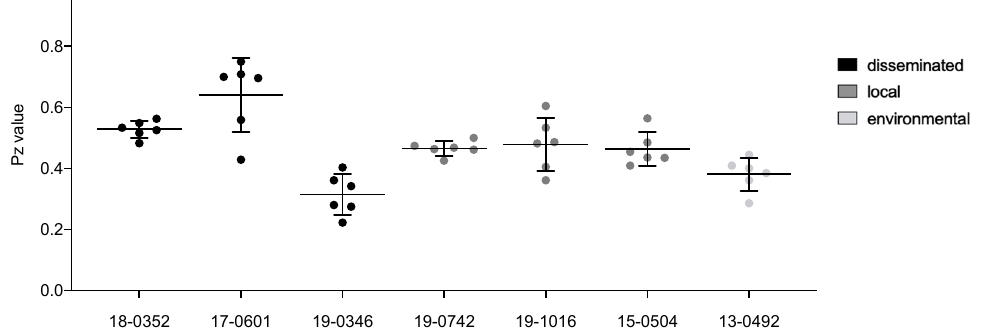
Figure 4. Phospholipase activity of Cryptococcus neoformans var. neoformans isolates from disseminated infections (black), localized soft tissue infections (grey), and the environment (light grey). A total of 5 µL containing 10 6 cells were spotted on egg yolk agar and incubated at 30 °C for five days. Halos surrounding colonies were measured digitally. Black lines show means with standard deviation of three biological replicates with two measurements each. Dots show individual data points.